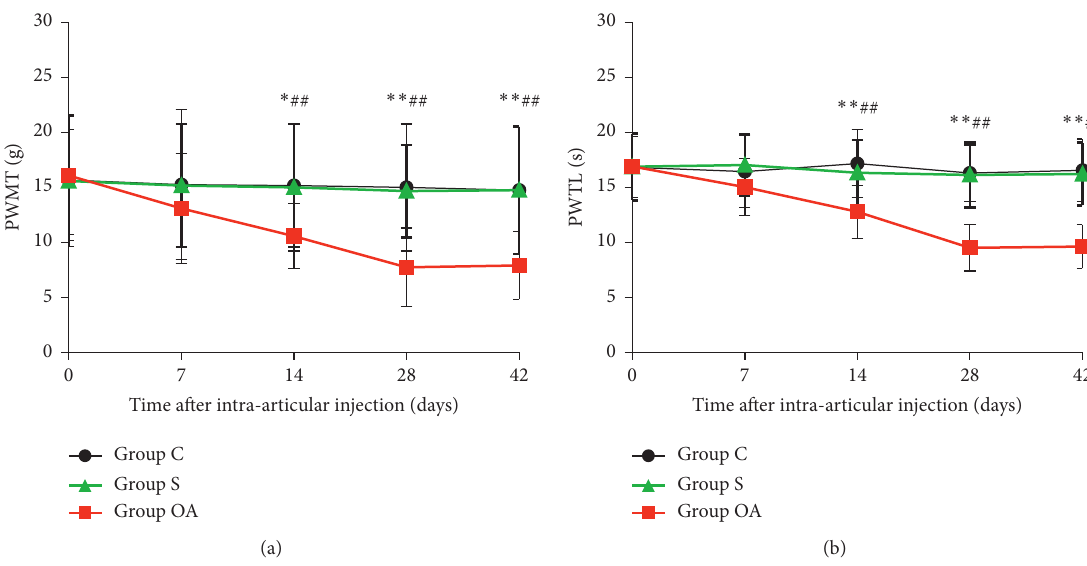
Figure 1: Comparison of PWMT (a) and PWTL (b) in the three groups of rats at each time point. Each symbol represents mean ± SD (standard deviation), n � 12 per group; ∗ P < 0 . 05, ∗∗ P < 0 . 01 vs. group C; # P < 0 . 05, ## P < 0 . 01 vs. baseline in the OA group. Repeated- measures ANOVA: (a) multiple groups; (b) multiple groups ×